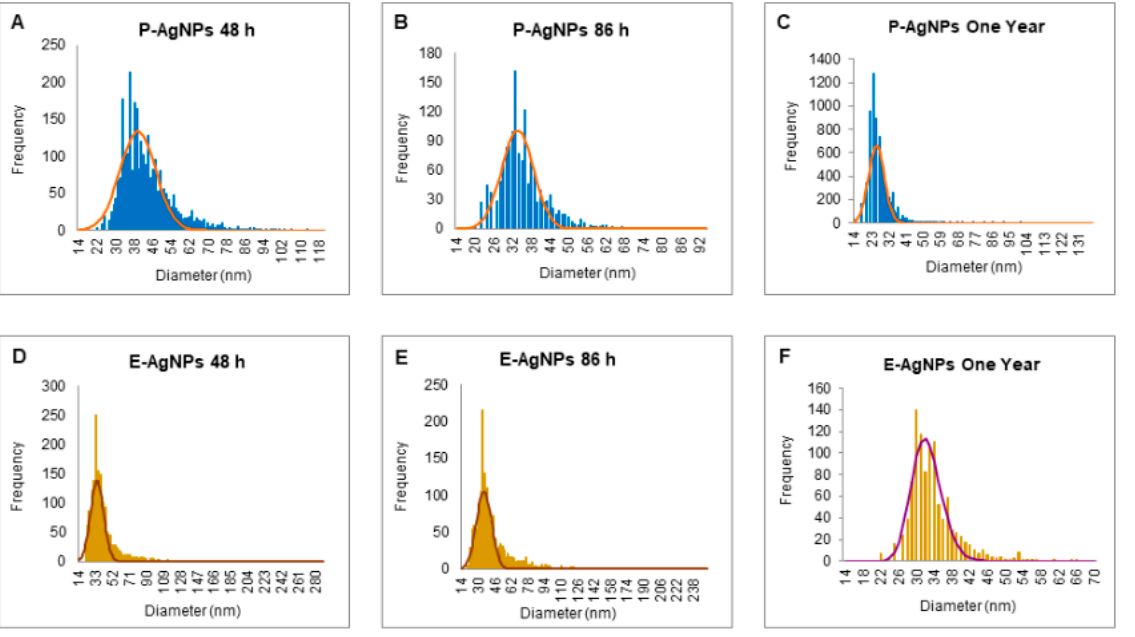
Figure 7. sp-ICPMS and stability analysis of P-AgNPs and E-AgNPs. ICPMS histogram of P-AgNPs at different time intervals, ( A ) after 48 h of synthesis at RT (room temperature), ( B ) after 86 h of synthesis at RT, ( C ) after one year at 4 °C. ICPMS histogram of E-AgNPs at different time intervals, ( D ) after 48 h of synthesis at RT, ( E ) after 86 h of synthesis at RT, ( F ) after one year at 4 °C.